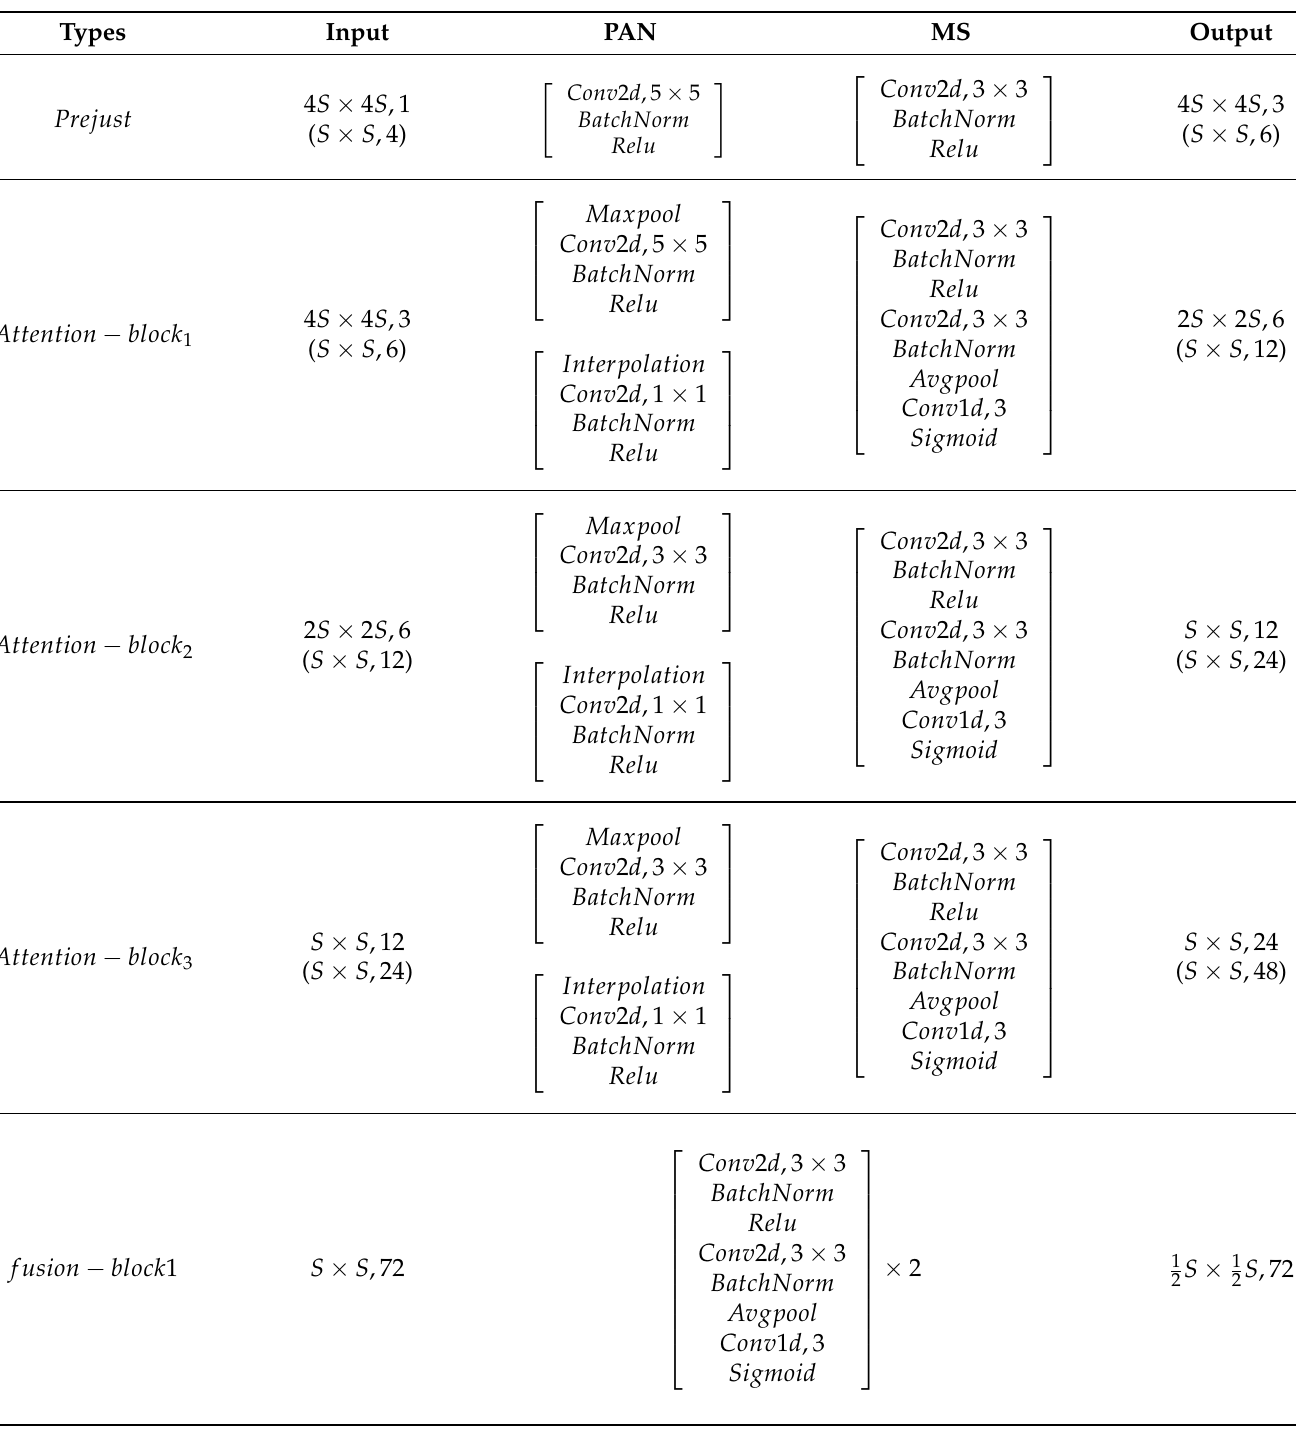
Table 1. The Hyper-Parameters of Each Network